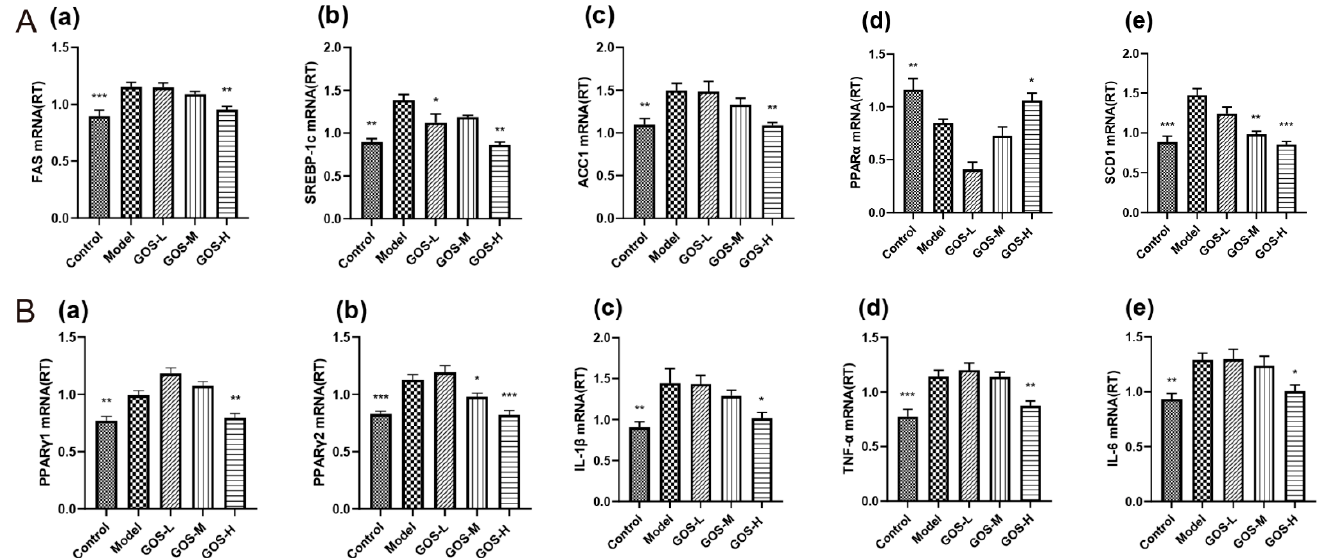
Figure 7. ( A ) Effects of GOS on the expression levels of FAS ( a ), SREBP-1C ( b ), ACC1 ( c ), PPAR α ( d ), and SCD1 ( e ) genes in mice liver ( n = 6, mean ± SEM). ( B ) Effects of GOS on the expression of PPAR γ 1 ( a ), PPAR γ 2 ( b ), IL-1 β ( c ), TNF- α ( d ), and IL-6 ( e ) genes in mice liver ( n = 6, mean ± SEM). Note: * p < 0.05, ** p < 0.01, *** p < 0.001 vs. the model group.